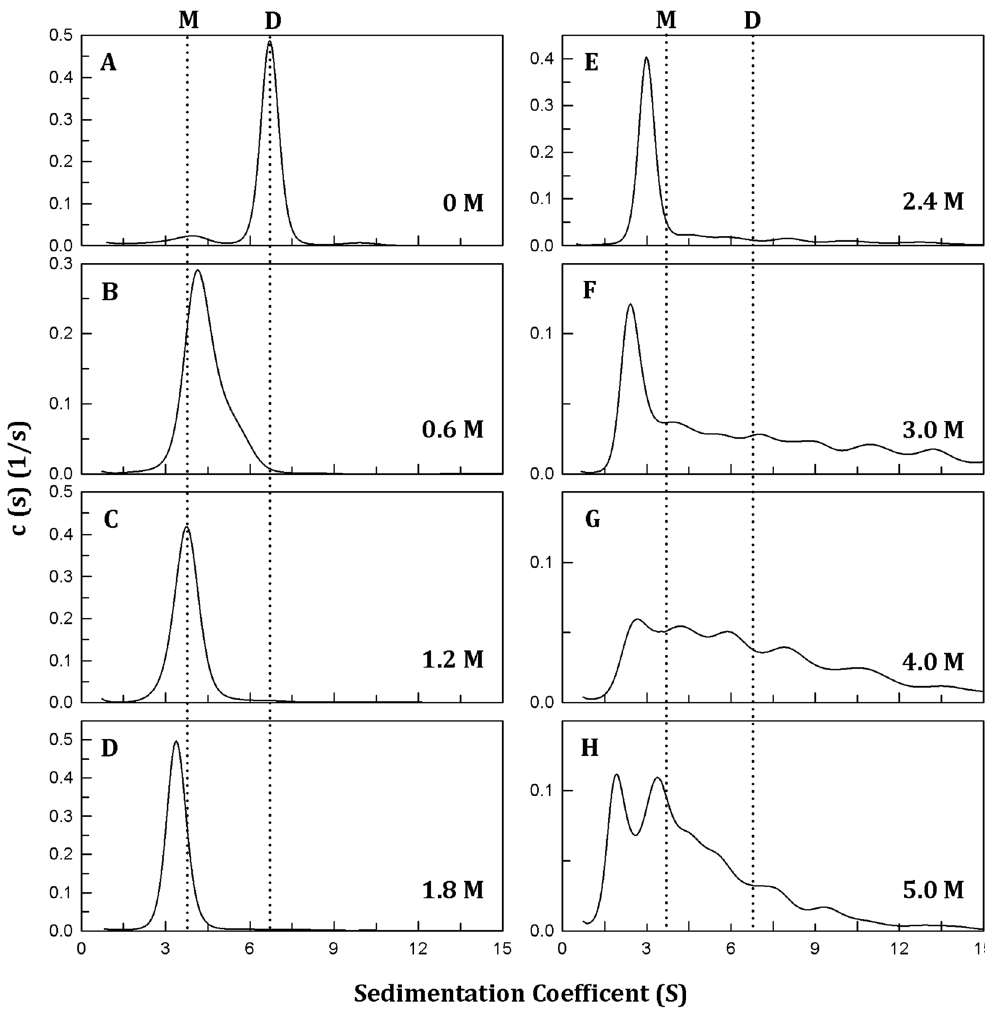
Figure 3. Continuous sedimentation coefficient distributions of human PAD4 WT enzyme during urea denaturation. The PAD4 WT enzyme (0.3 mg/ml) in the presence of 10 mM Ca 2 + was treated with various concentrations of urea in 50 mM Tris-HCl buffer (pH 7.4) at 25 °C for 16 h: ( A ) 0 M urea, ( B ) 0.6 M urea, ( C ) 1.2 M urea, ( D ) 1.8 M urea, ( E ) 2.4 M urea, ( F ) 3.0 M urea, ( G ) 4.0 M urea and ( H ) 5.0 M